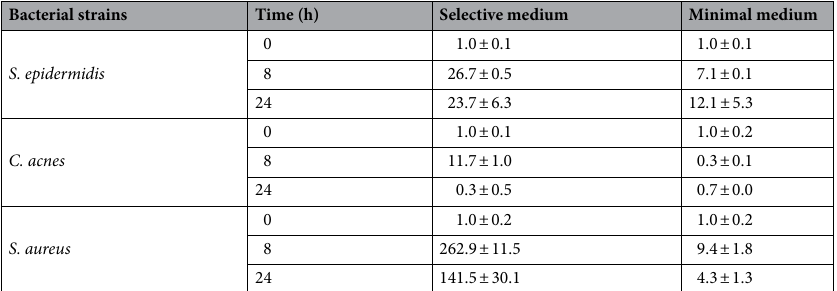
Table 1. Bacterial strains growth comparison between selective and minimal medium in absence of scFOS. Spread plate colony count, expressed as fold-change compared to the bacterial load of the initial inoculum, following exposure of S. epidermidis, C. acnes or S. aureus to selective and minimal medium for 8 and 24 h, in absence of scFOS. Results are expressed as mean ±